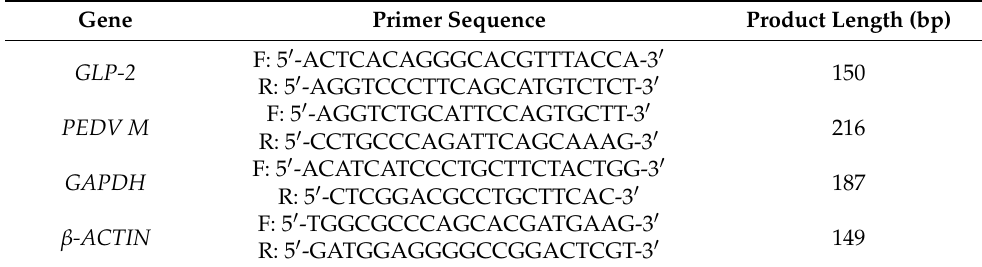
Table 1. The primer sequence of genes for